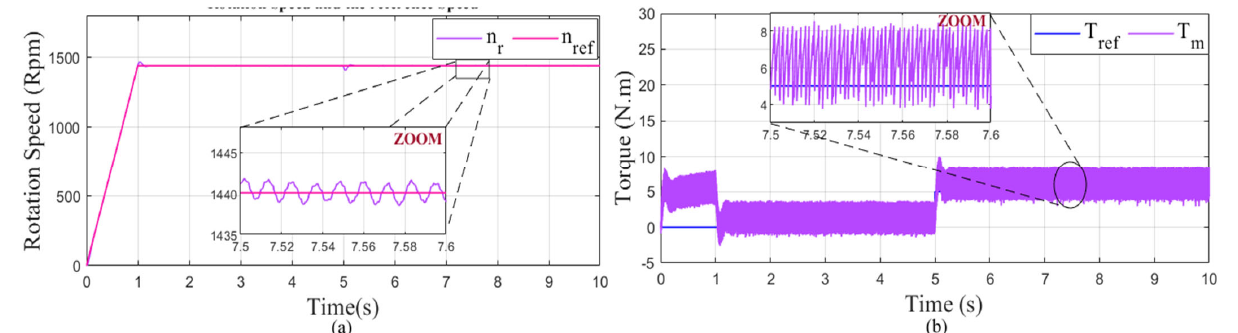
Figure 27. Performance with IR bearing defect of IM with DTC control: ( a ) rotation speed and ( b ) motor torque.